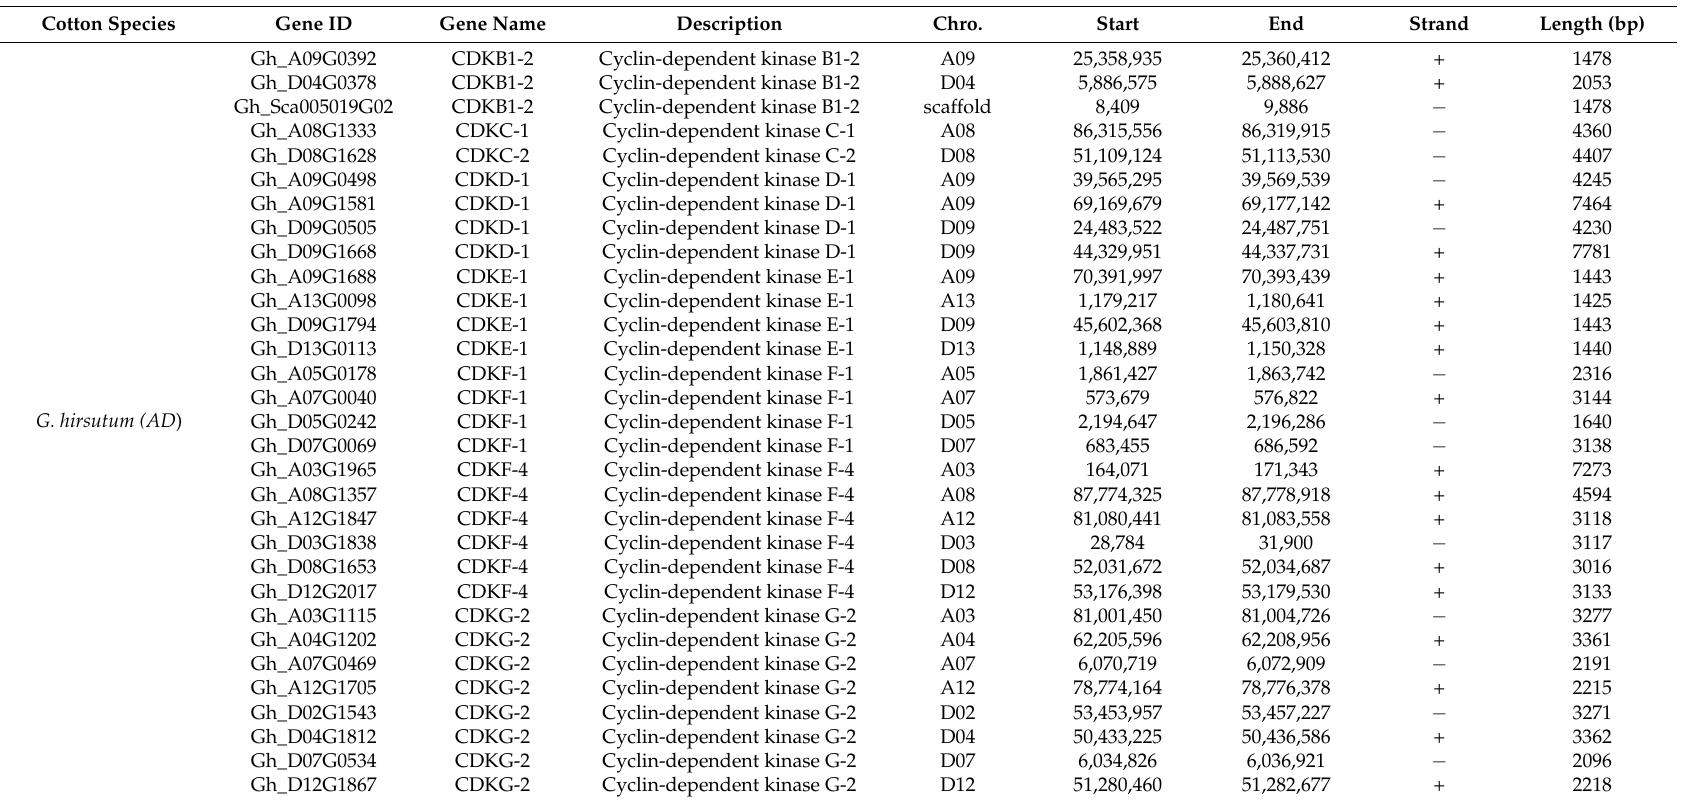
Table 1. Identification and chromosomal distribution of the cotton CDK